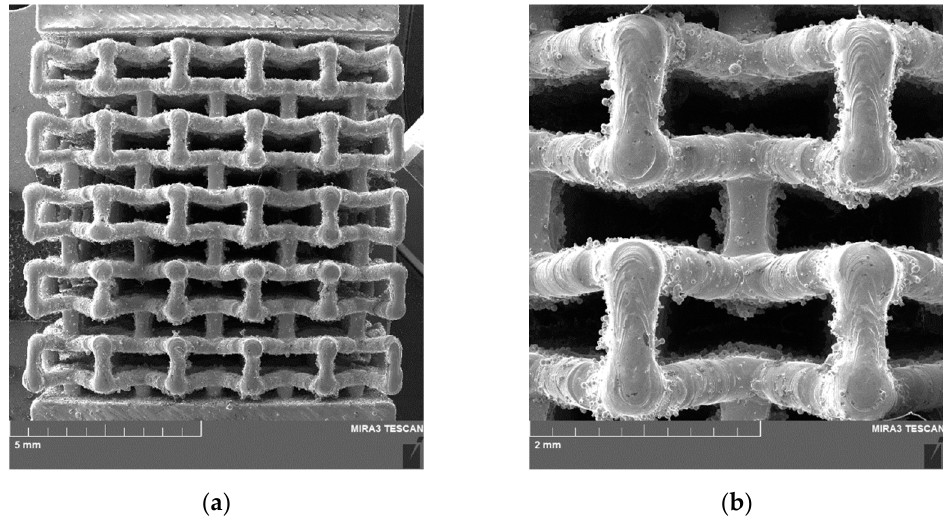
Figure 6. SEM images of the fabricated lattice structure based on a single Type 5 cell. ( a ) General view; ( b ) Highly magnified view of two cells.